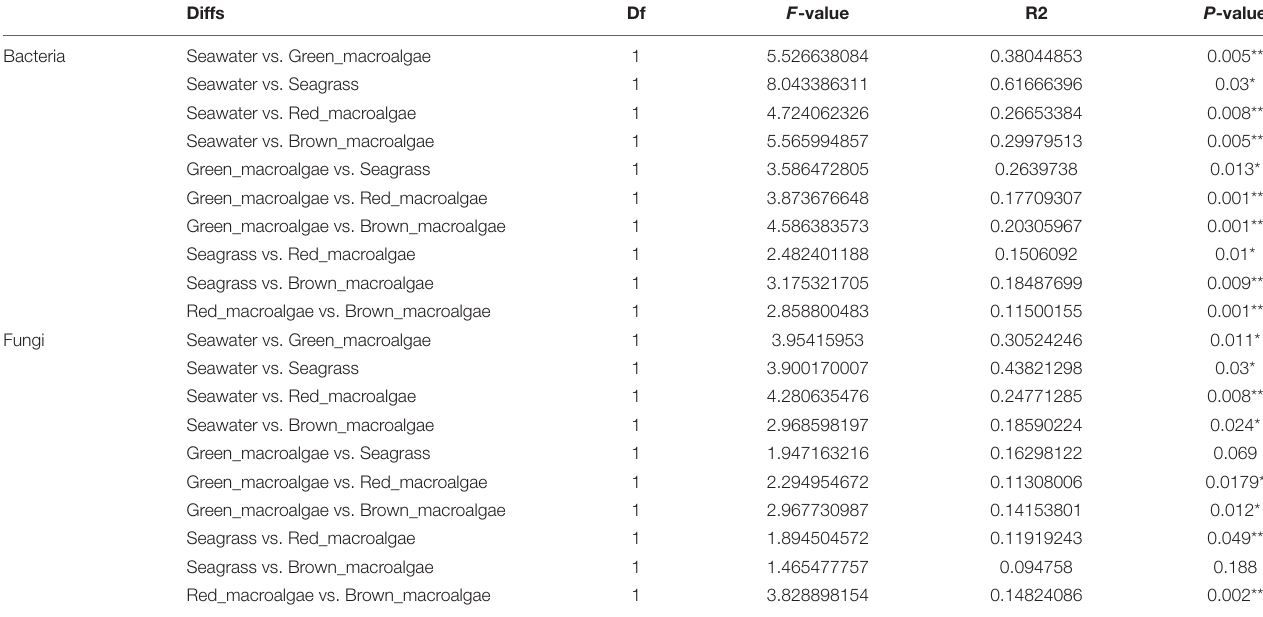
TABLE 1 | Statistical analysis of the seawater, green macroalgae, red macroalgae, brown macroalgae, and seagrass using “adonis”. Diffs Df F -value R2 P -value Bacteria